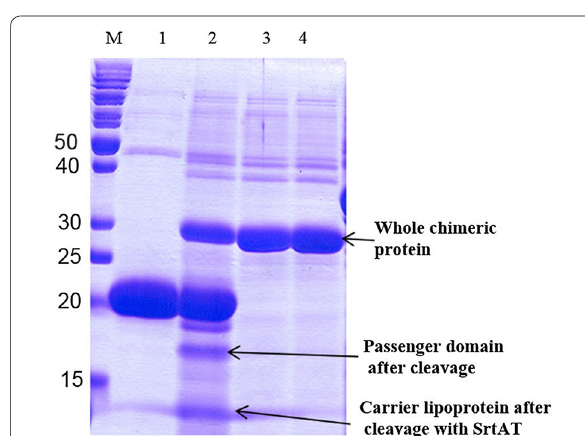
Fig. 4 Analysis of sortase activity on LO-Mt-Ch chimeric protein. M: molecular weight marker. Lane 1: recombinant srtA, synthesized in this study. Lane 2: the chimeric protein was partially processed into two fragments of 16 (Mt-Ch) and 14 kDa (Lpp ′ -ompA) after treatment by sortase (In vitro sortase assay). Lanes 3 and 4: the chimeric protein with out treatment with sortase